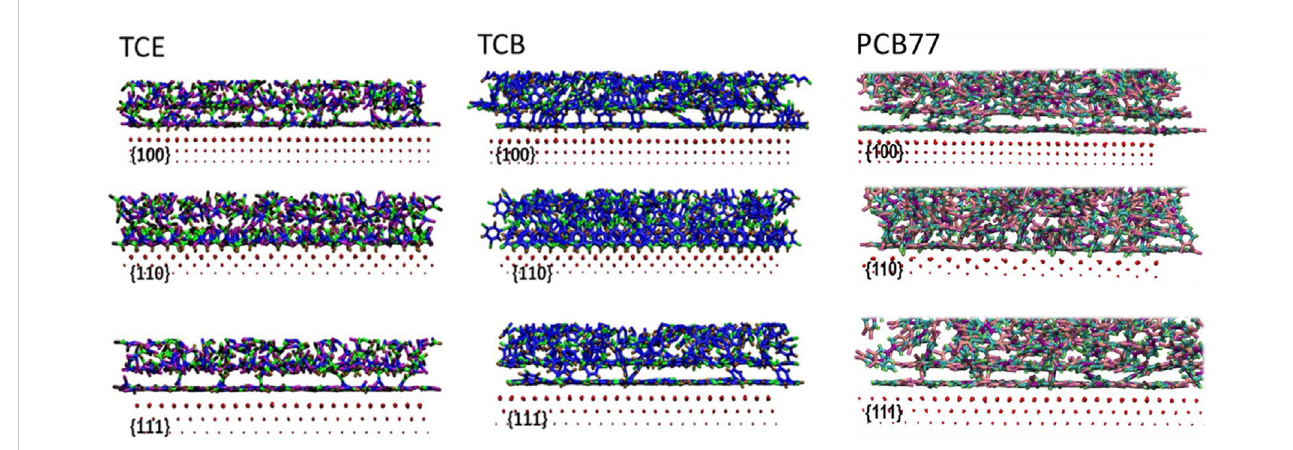
FIGURE 2 SideviewsnapshotsattheadsorbedstateforTCEat230 K(leftpanel),TCBat360 K(middlepanel)andPCB77at500 K(rightpanel)forthreefacets.Only the fi rst three layers ofPd are shown. The size of the Pdatoms correspond to their respective distance from the organic interface. The following color code is used: Pd in red in all fi gures; (1) left panel: TCE carbon (blue) bonded to two chlorines (violet), the other TCE carbon (cyan) bonded to one chlorine (brown), TCEhydrogen(black);(2)middlepanel:TCBcarbons(blue),chlorines(cyan),andhydrogens(brown);and(3)rightpanel:PCB77biphenylcarbon(purple), PCB77 carbon (peach) bonded to chlorine (pink), PCB77 carbon (cyan) bonded to hydrogen